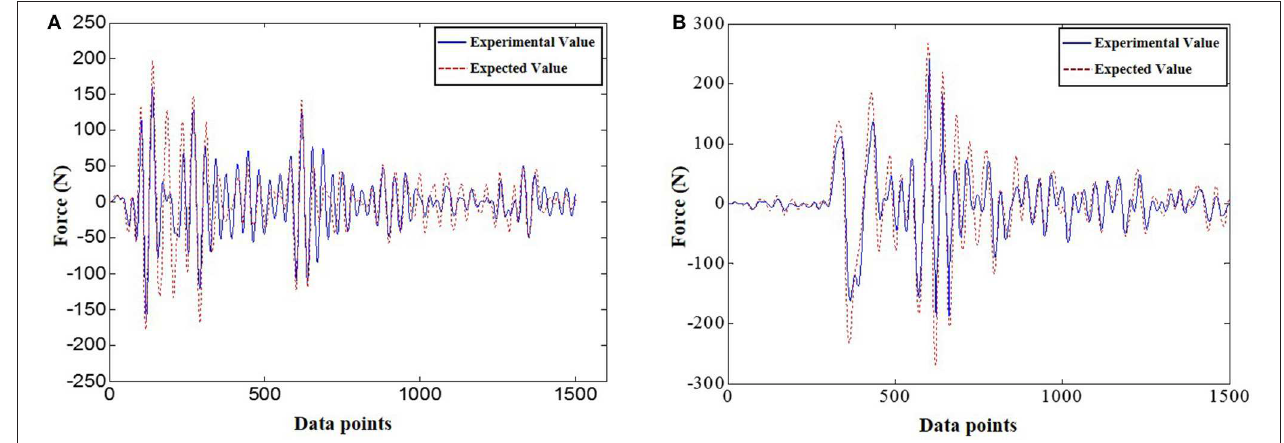
FIGURE 8 | Comparison between experimental value and expected value under different earthquake wave. (A) El-Centro earthquake wave. (B) Tianjin earthquake